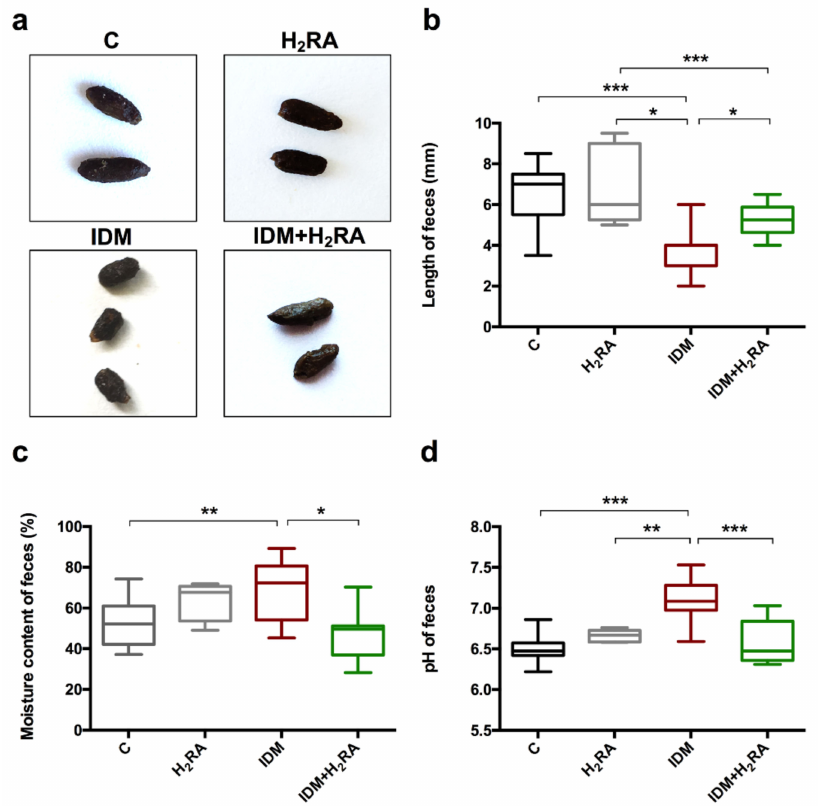
Figure 2. State of feces in Indometacin (IDM)-induced intestinal mucosal injury model with or without histamine H 2 -receptor antagonists (H 2 RA) administration. Fecal samples were collected from the 50 mice (16 control, 5 H 2 RA only, 13 IDM, and 16 IDM + H 2 RA mice) on day 2 after IDM